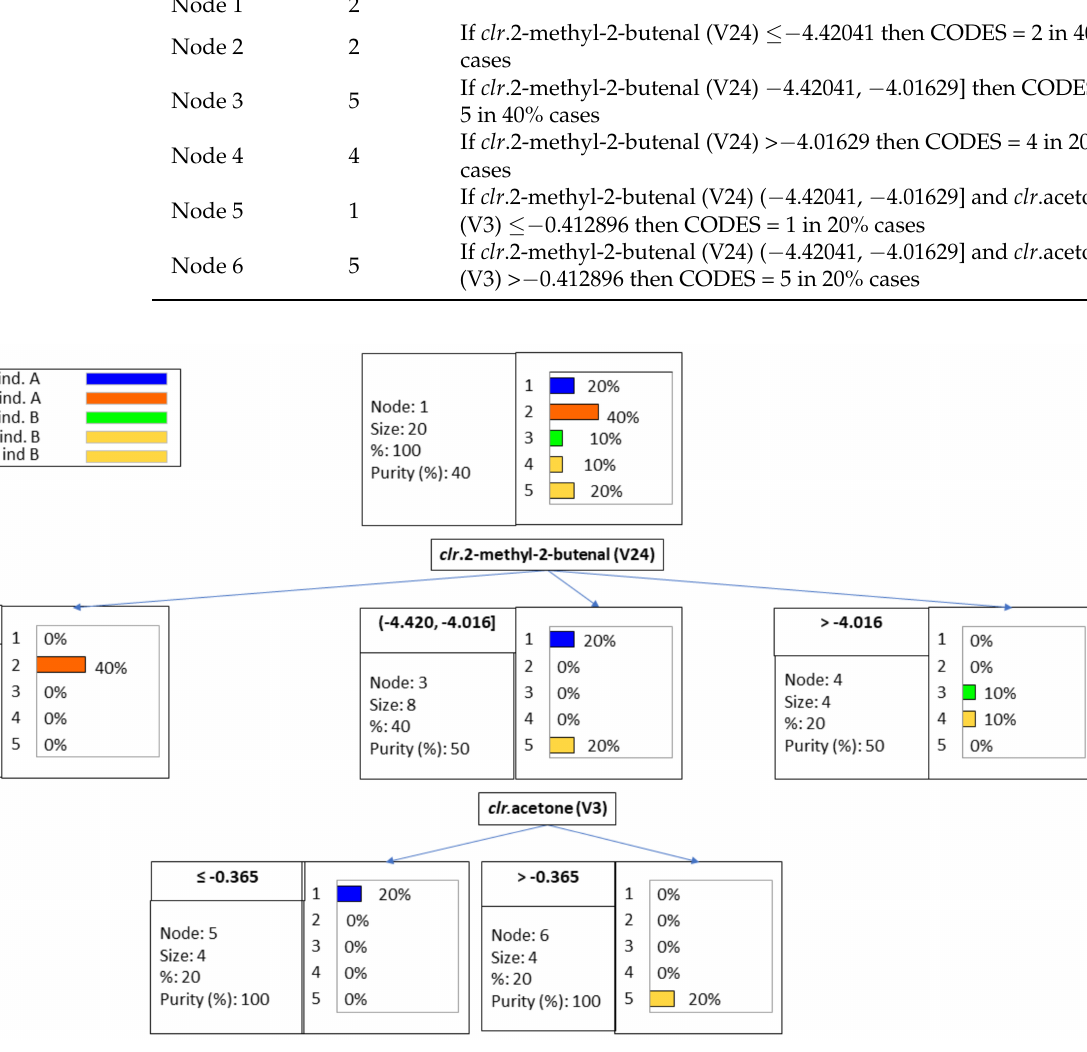
Figure 3. Classification tree of samples, using the clr coefficients of the original data set. Notice the simple prediction by just a few